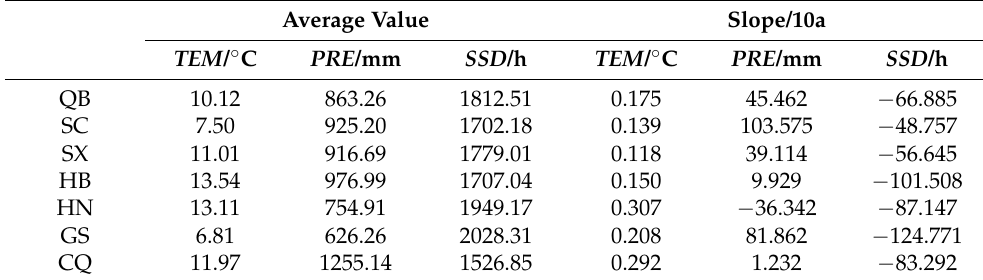
Figure 8. The spatial pattern changes of climate factors in the QBM from 2000–2020: ( a ) TEM ; ( b ) PRE ; ( c ) SSD . (1. Annual average; 2. Change trend rate). Table 5. Annual average and change trend rate of climate factors in the QBM.